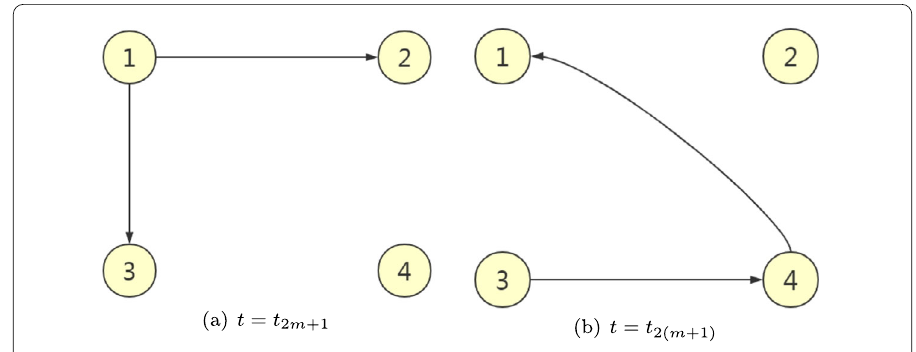
Figure 5 Communication topology among four NNs of G x , m ∈ Z +